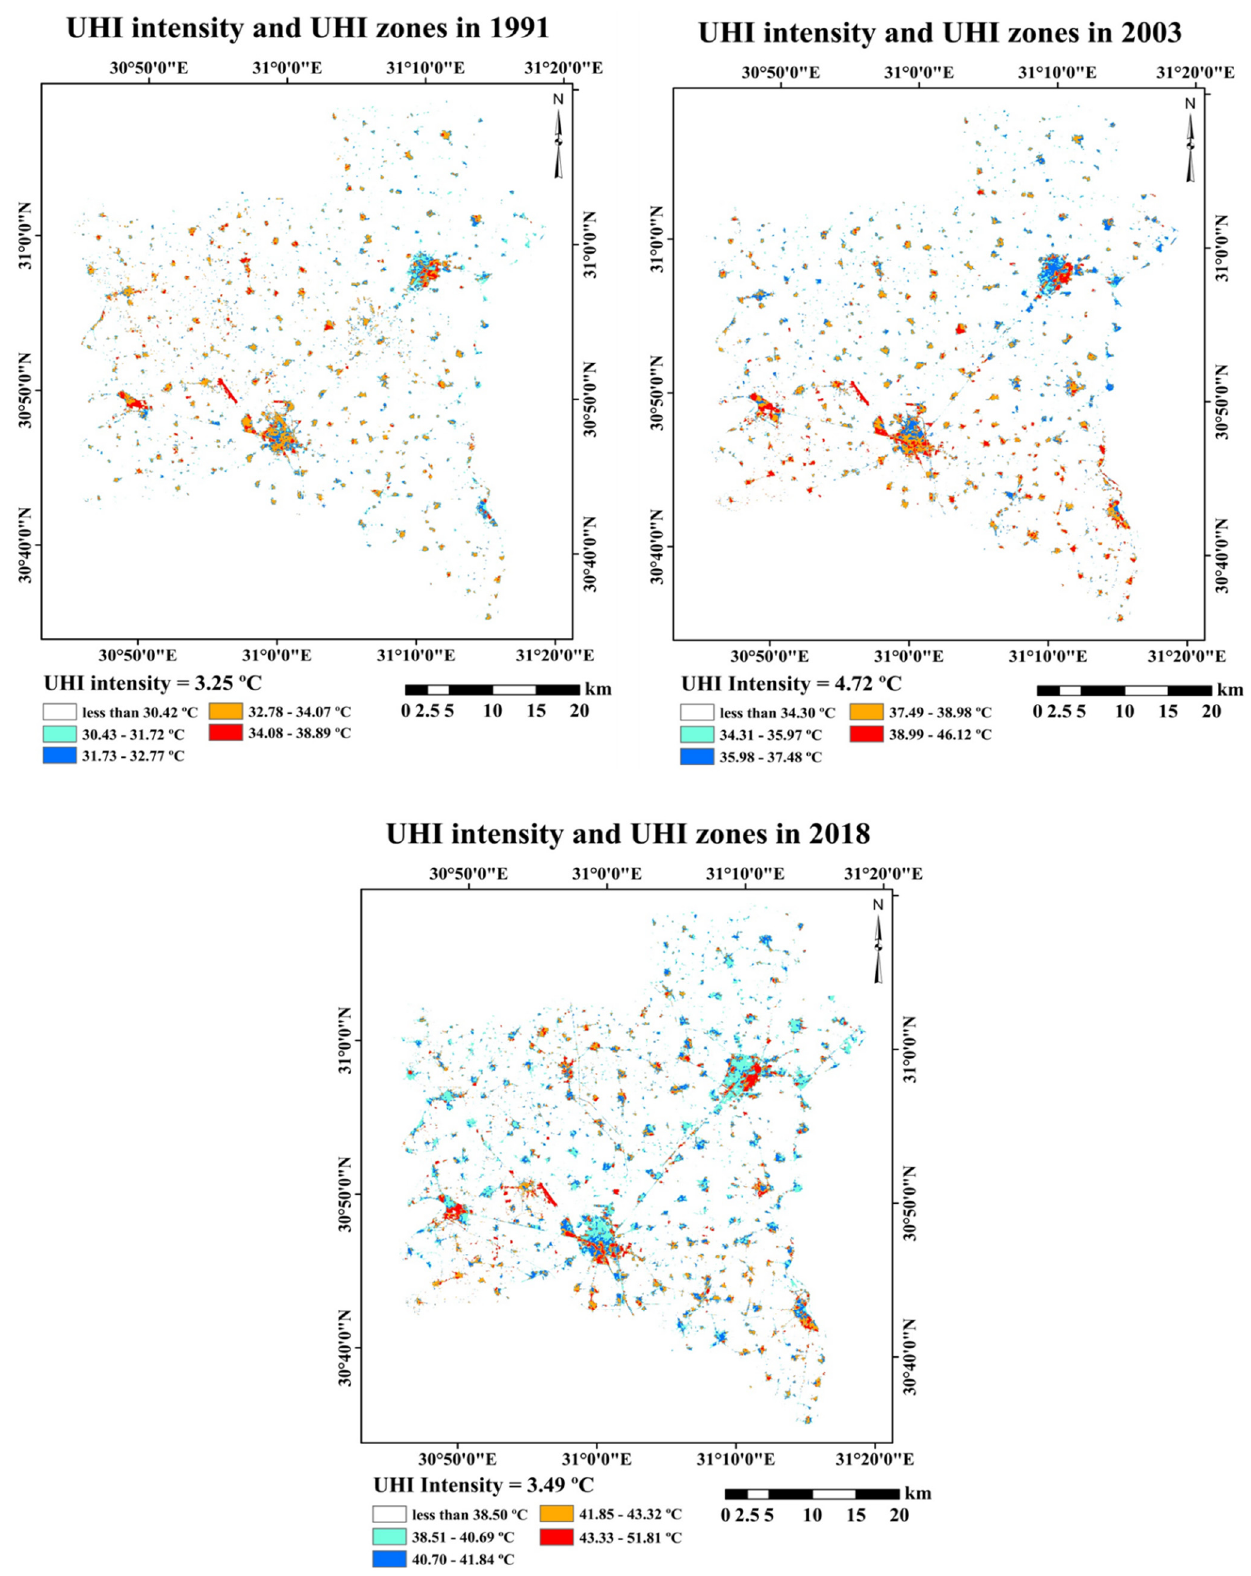
Figure 8. Land surface temperature maps illustrating UHI intensity and UHI zones. The white color represents non-UHI zones, and UHI intensity is mentioned for each image.